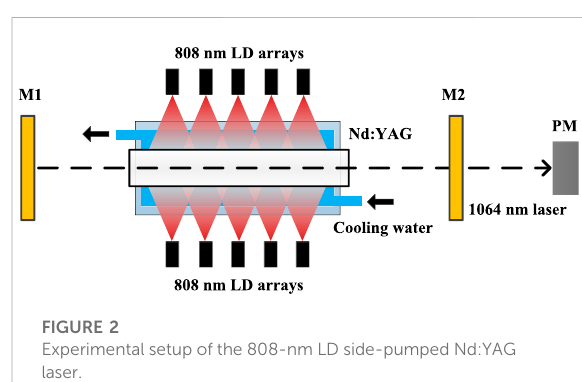
FIGURE 2 Experimental setup of the 808-nm LD side-pumped Nd:YAG laser.